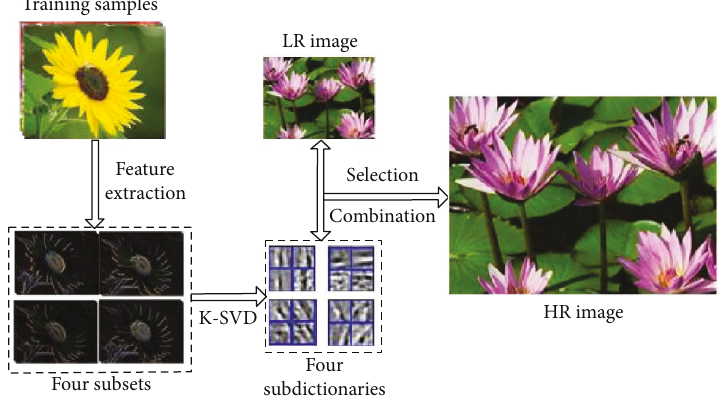
Figure 2: Process of SR reconstruction.